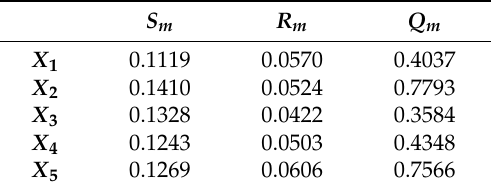
Table 11. The final evaluation result of candidate